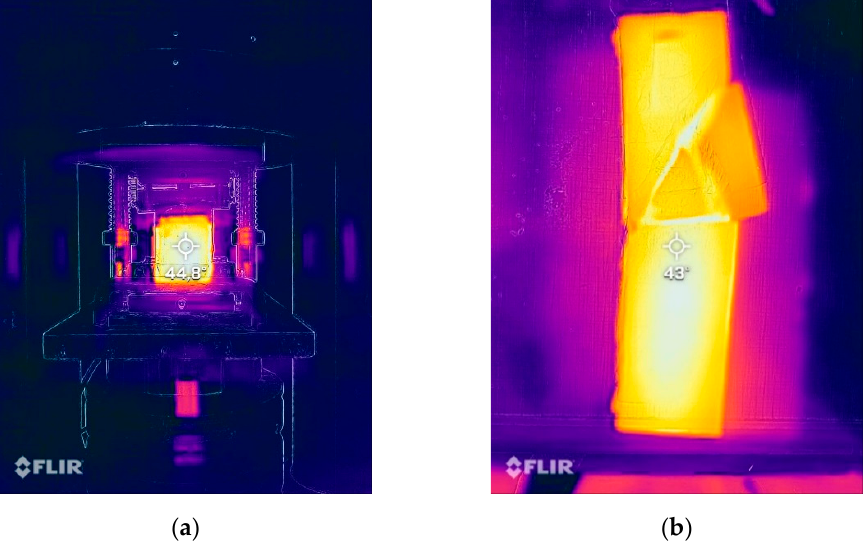
Figure 7. Measurement of change in thermal radiation made using an FLIR thermal imaging camera:=. ( a ) Sample during the bending test. ( b ) Sample after the bending test.